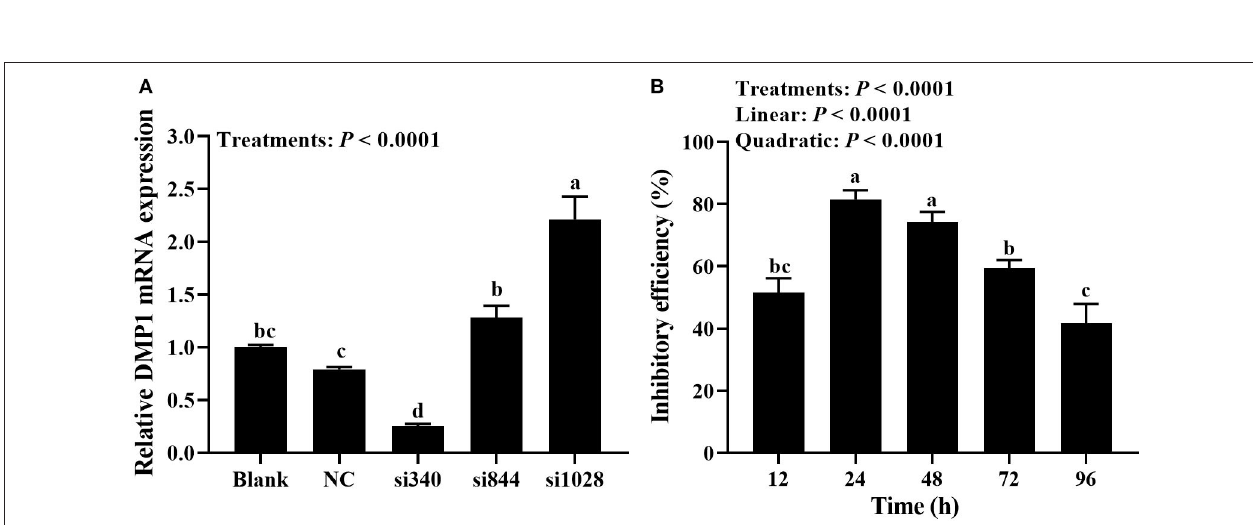
FIGURE 3 | Detection of transfection efficiency and selection of next time point for transfection (experiment 2). (A) Screening of the most effective siRNAs against DMP1 mRNA; (B) Effective time of si340 against DMP1 mRNA. Relative mRNA expression of DMP1 was calculated using the 2 − 11 Ct method, and the data were normalized by the geometric mean of two internal reference genes β -actin and GAPDH . All values are expressed as means ± SE, n = 6. Means without a common letter differ, P < 0.05. DMP1 , dentin matrix protein 1.